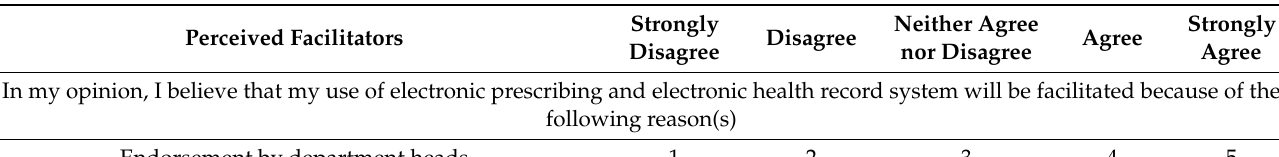
Table A5. Electronic Health Record System in Antim Crobial